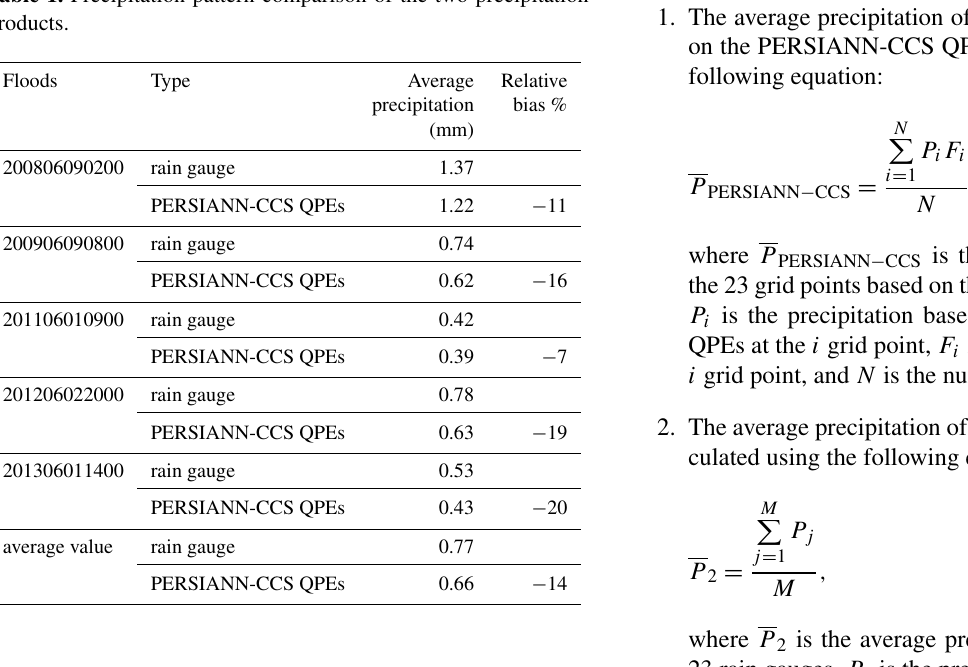
Figs. 4–8. For further comparison, the average precipitation of the five karst flood events was calculated, and the results are shown in Table